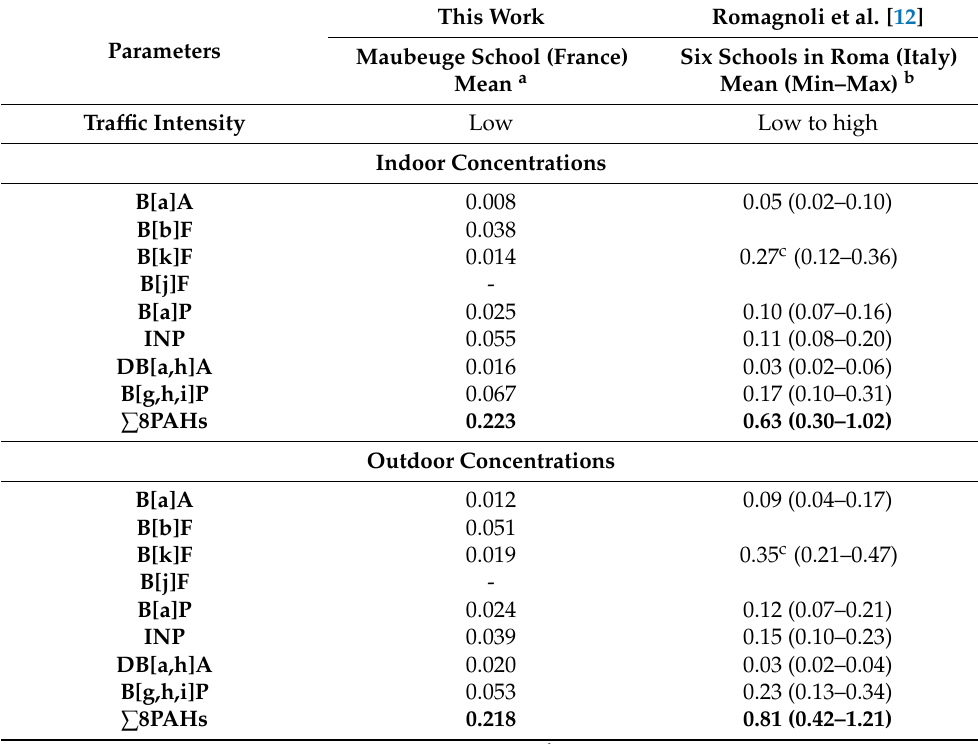
Table 3. Comparison of PM2.5 bound PAHs concentrations (in ng m − 3 ) measured indoors in this work and during the Italian study EXPAH [12]. The bold numbers correspond to the sum of the concentrations indoors or